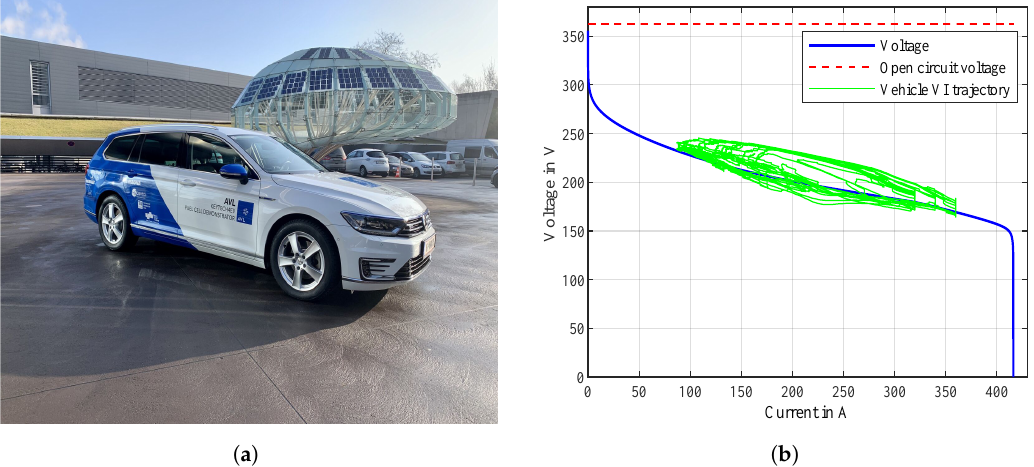
Figure 3. Keytech4EV research vehicle and its measured V-I trajectory superimposed to the simulated polarization curve brought for visualization of the operating range. ( a ) Vehicle developed by AVL List GmbH from which the data has been acquired for the validation of this study. ( b ) Measured V-I trajectory of the